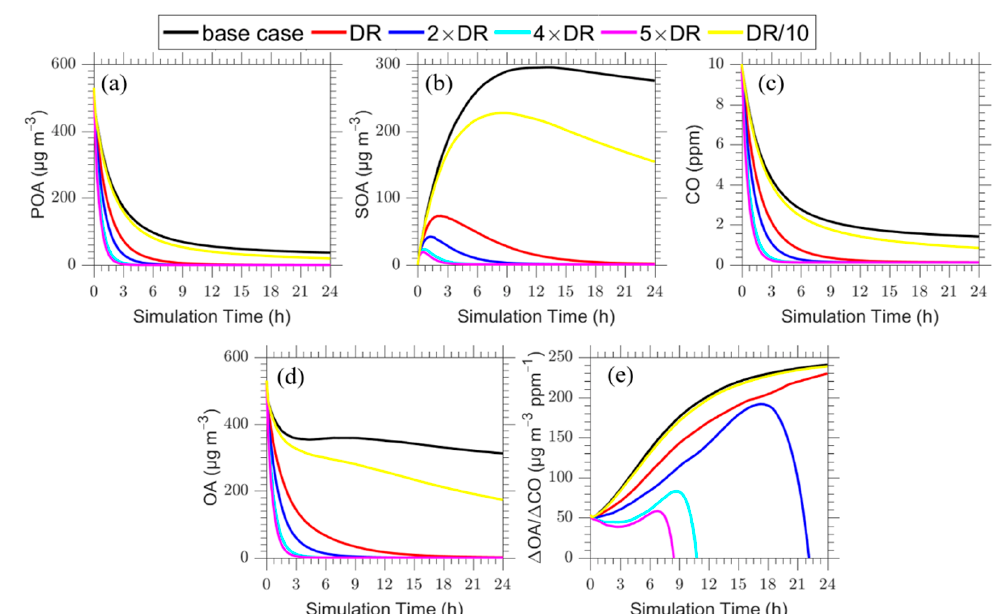
Figure 10. Time series of: ( a ) POA; ( b ) SOA; ( c ) CO; ( d ) total OA; and ( e ) ∆ OA/ ∆ CO for the plume centerline for the base case (black line) in comparison to the cases with dilution rate constants DR equal to 10 − 4 s − 1 (red line), and increased dilution rate by a factor of 2 (blue line), 4 (cyan line) and 5 (magenta line) and decreased dilution rate by a factor of 10 (yellow line).